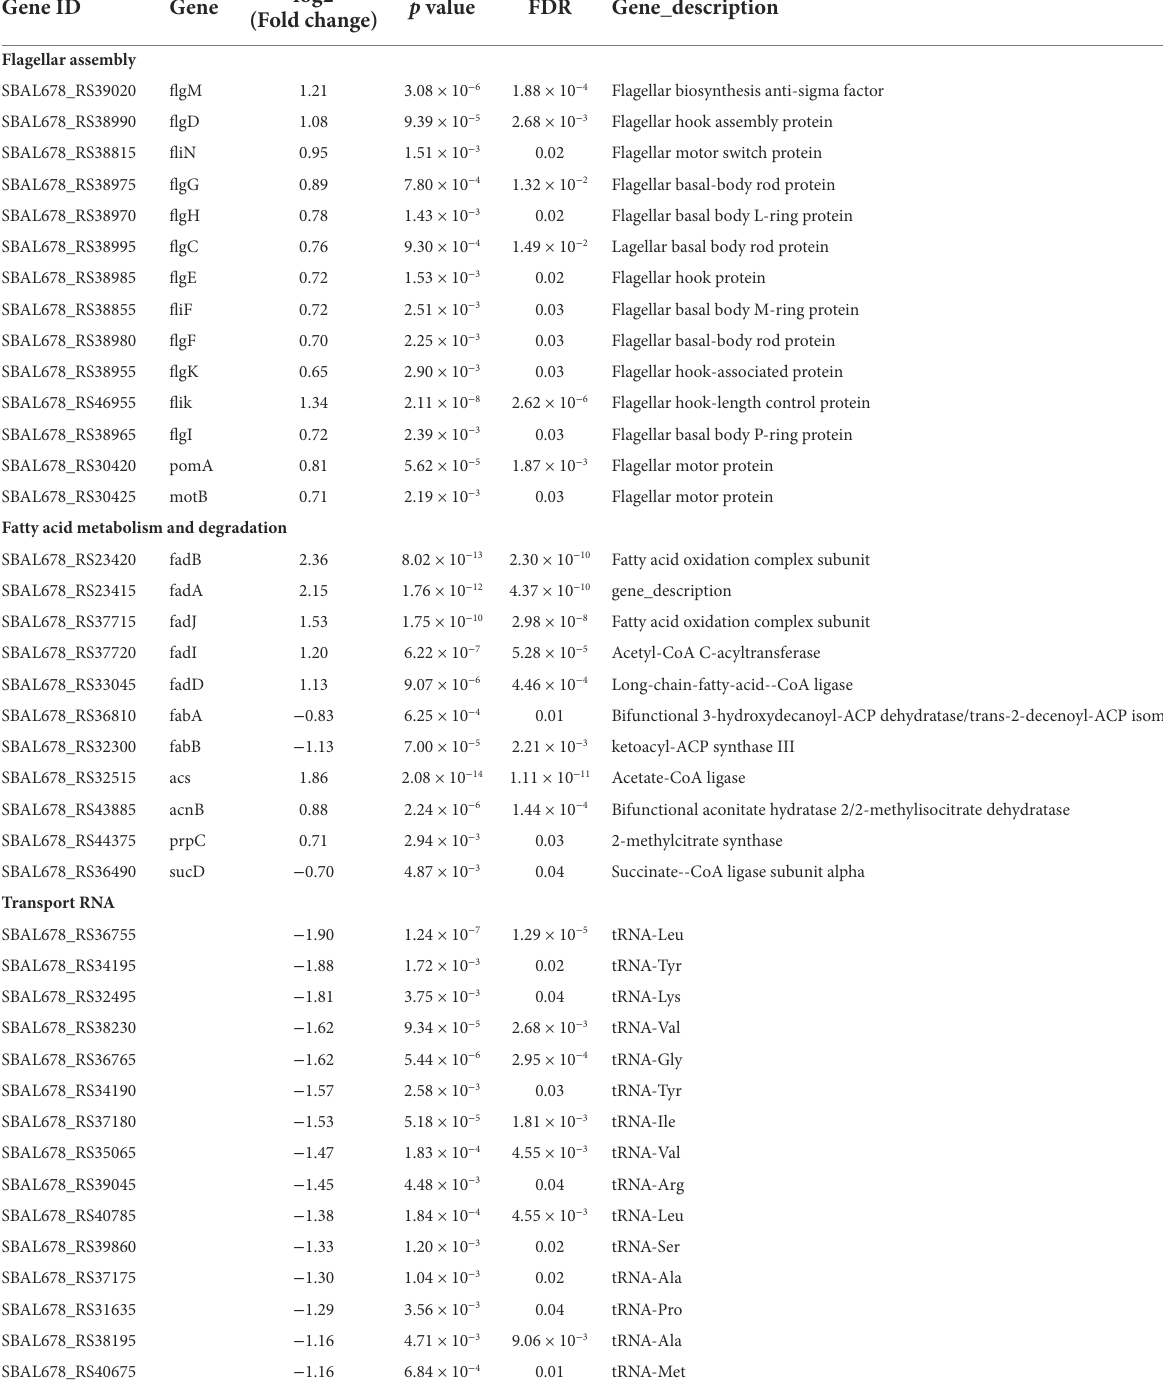
TABLE 1 Representative differently expressed genes in the Shewanella baltica wild type and rpoS mutant. log2 Gene ID Gene p value FDR Gene_description (Fold change) Flagellar assembly